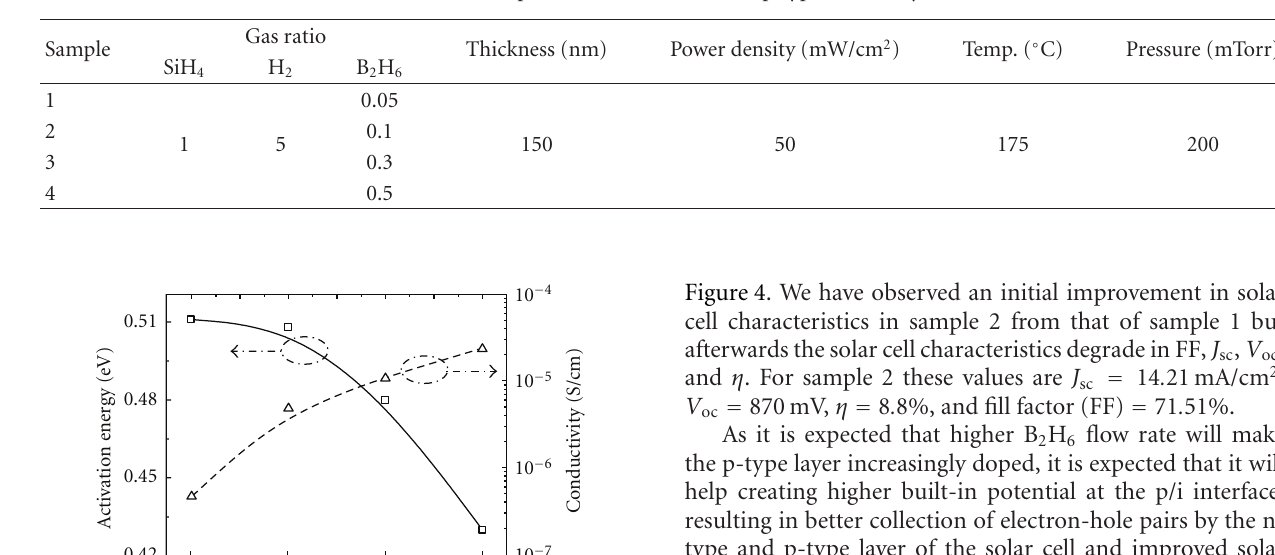
Figure 2: XPS spectrum of the B(1s) signal of the boron-doped amorphous silicon layers. It is deconvoluted into two Gaussian peaks, as shown in (b). Table 1: The deposition conditions for the p-type a-Si: H layers.